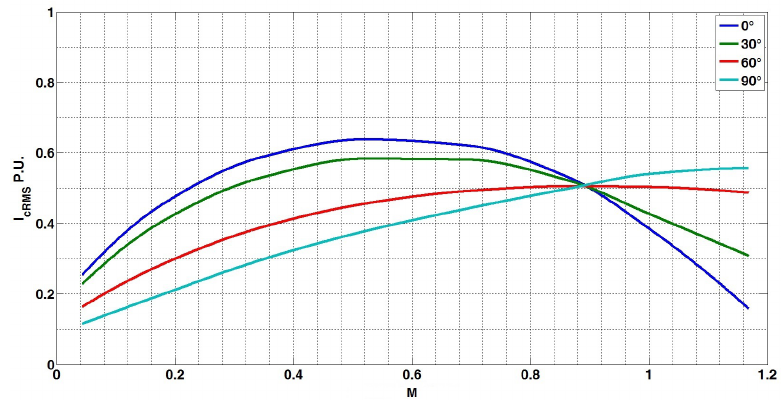
Figure 8. Simulated results: 3-phase machine q 3/10 3-phase powered: I C value of electric angle between voltage and current